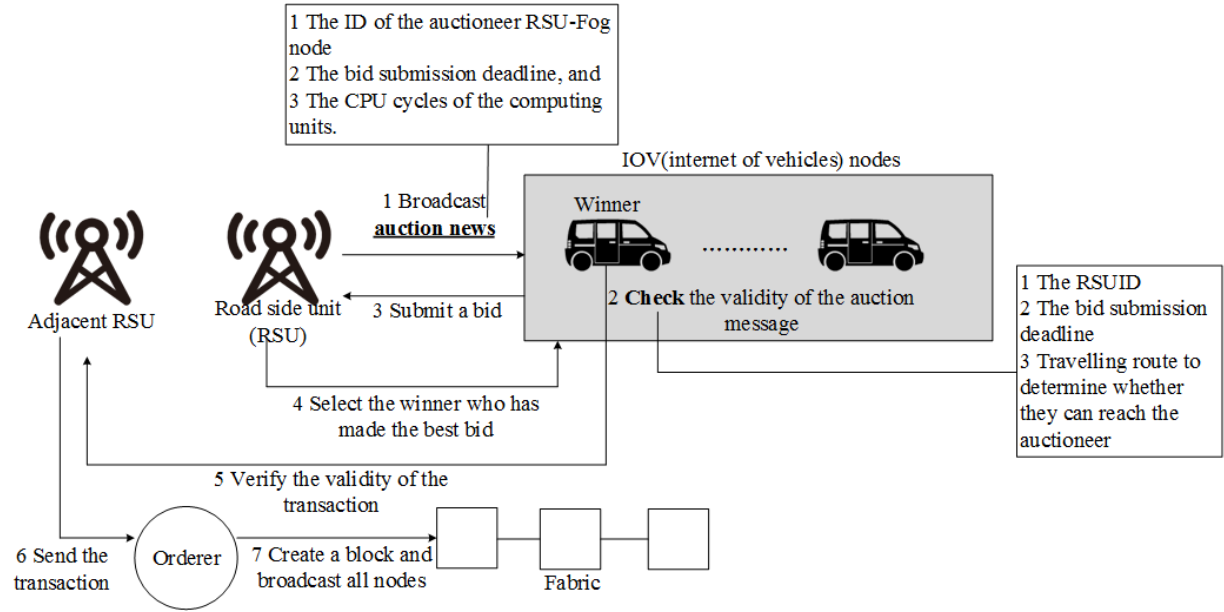
Figure 43. Reconstruction diagram of reference [75].